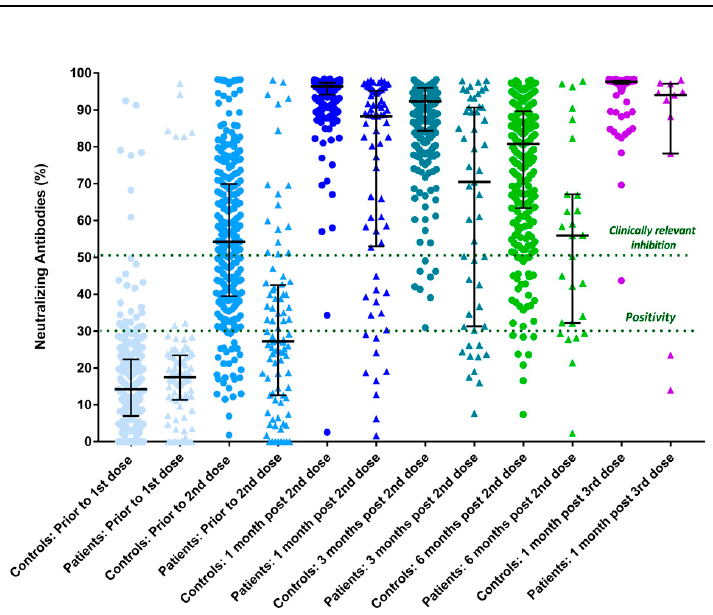
Figure 1. Kinetics of neutralizing antibodies (NAb) in cancer patients receiving targeted therapies and matched controls, at several timepoints after COVID-19